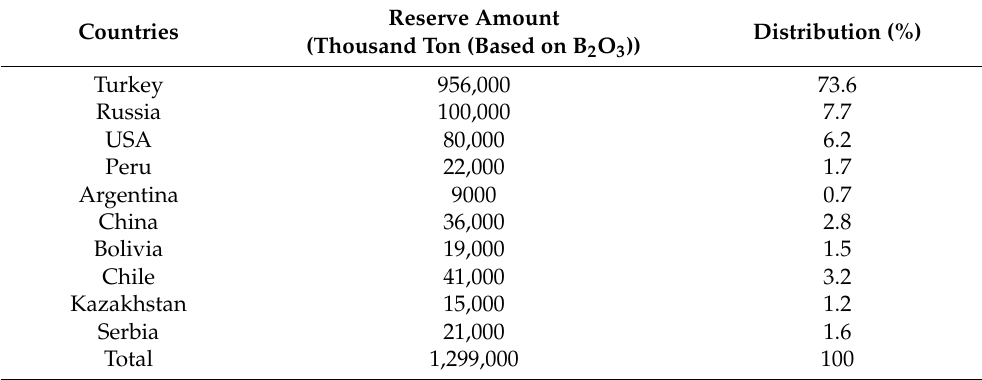
Table 2. World Boron Reserve 2020 [33,34].